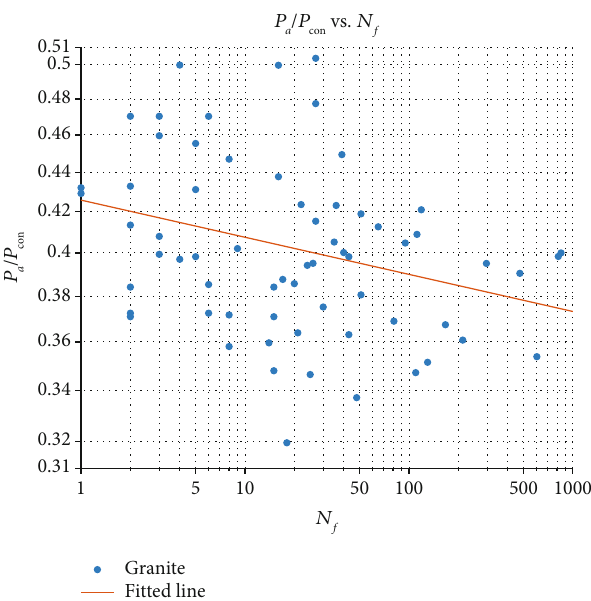
P Figure 13: P versus N f for cyclic injection tests on granite. a / con The red line is the fi tted line.